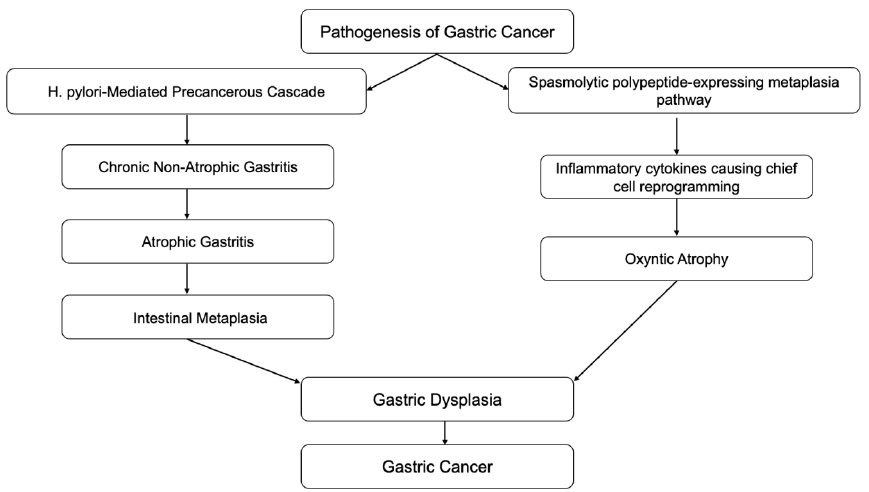
Figure 1. Correa Figure 1. Correa cascades.